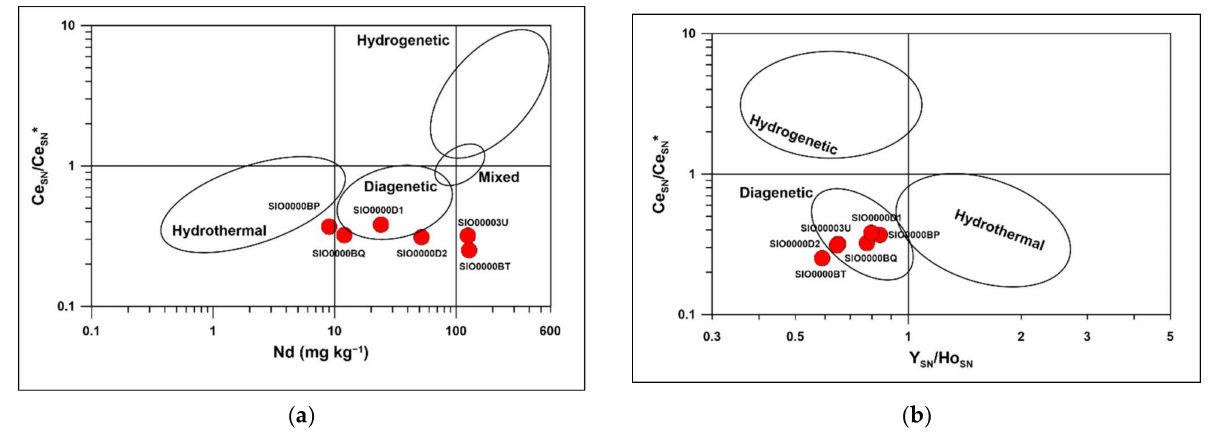
Figure 9. Discrimination diagrams of Mn-Fe crusts from C-NSC: ( a ) Ce SN /Ce SN * ratio vs. Nd concentration; ( b ) Ce SN /Ce SN * ratio vs. Y SN /Ho SN ratio [72]. SN = PAAS-normalized